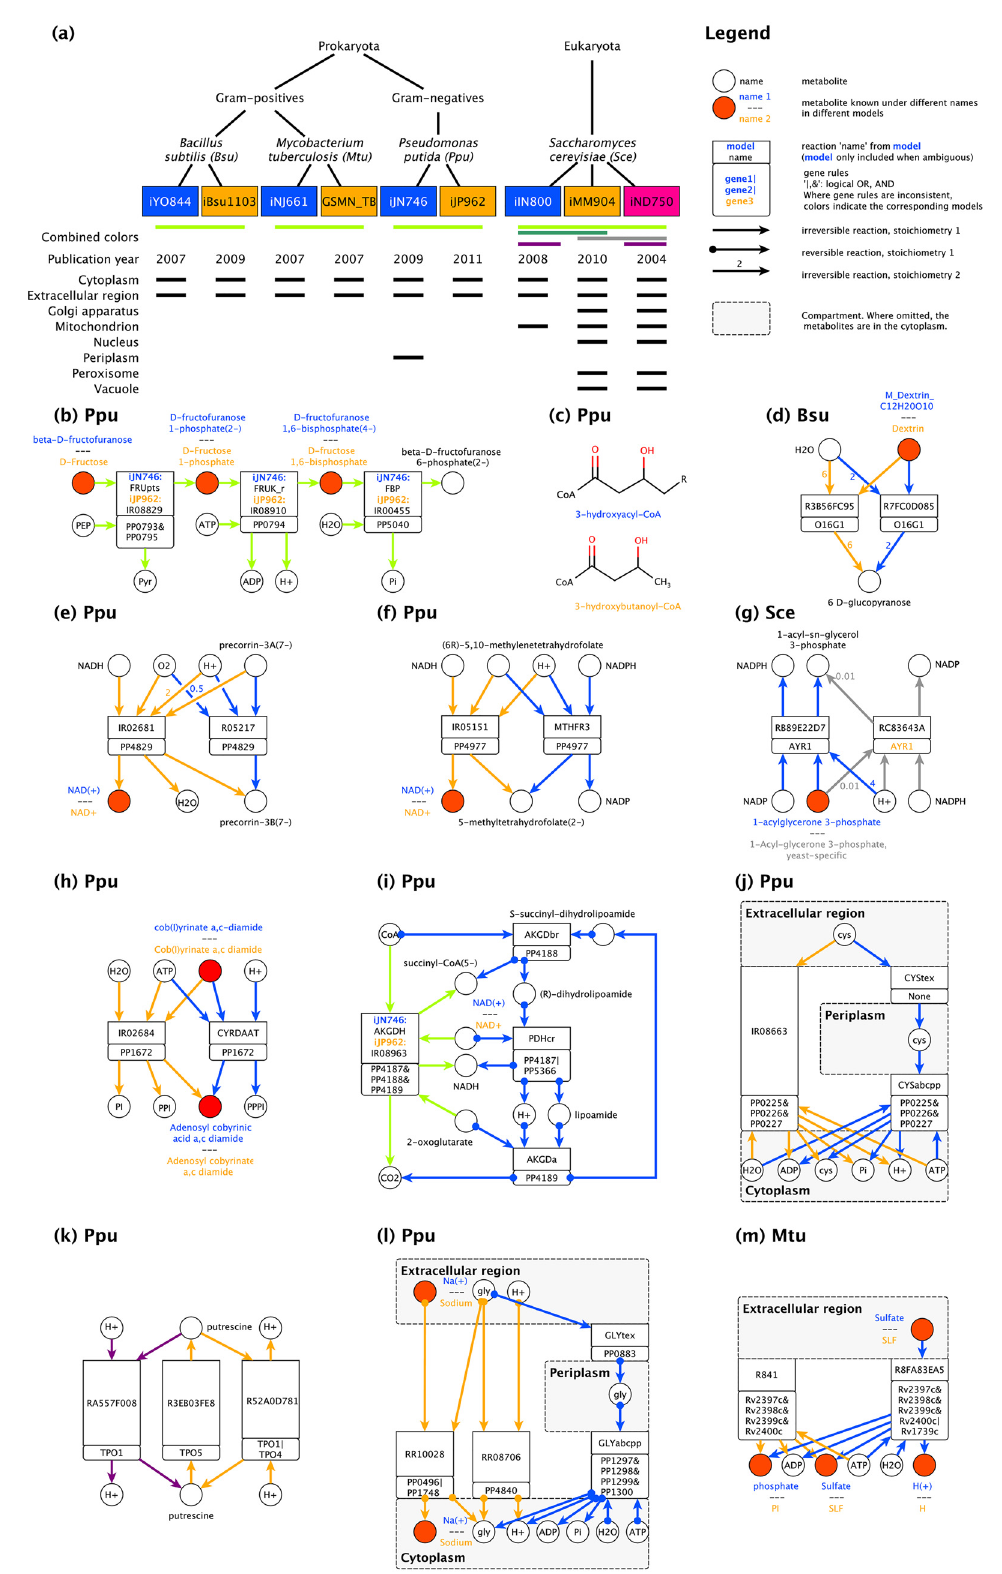
Fig 1. Models used in this study and classification of inconsistencies. ( a ) Overview of the used initial GSMs. ( b ) Instances of identical metabolites with different MnXRef identifiers. ( c ) Non-identical metabolites that